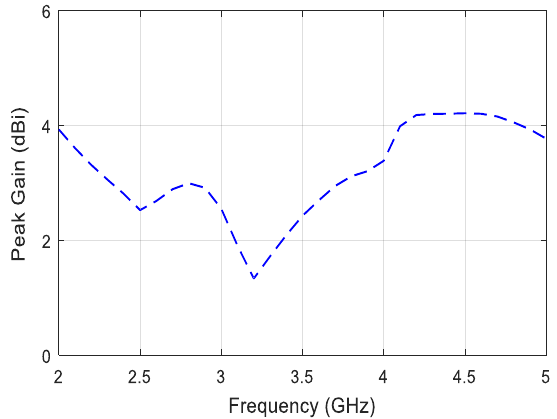
Figure 8. Peak gain of the proposed PLPA.